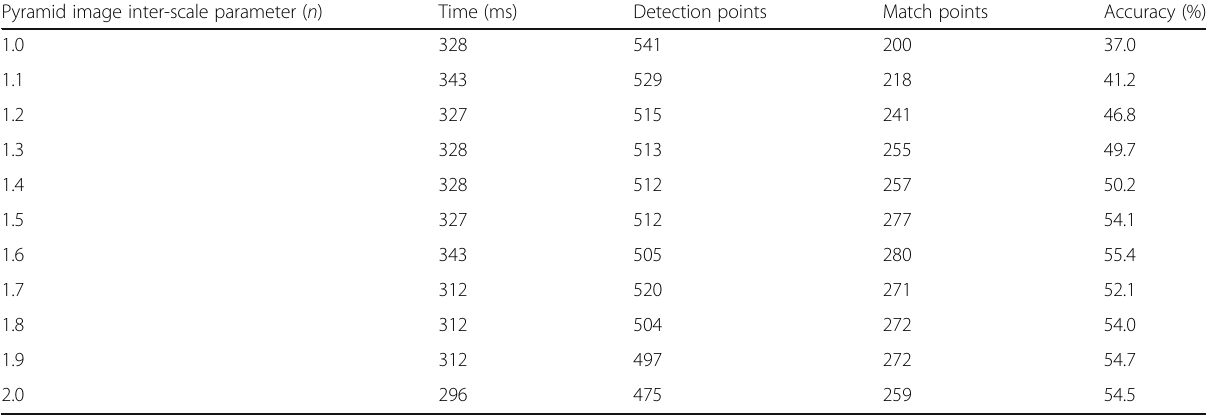
Table 1 Statistical table of the results of the gradual change of the scale parameters between the images when the pyramid layer is 4 Pyramid image inter-scale parameter ( n ) Time (ms) Detection points Match